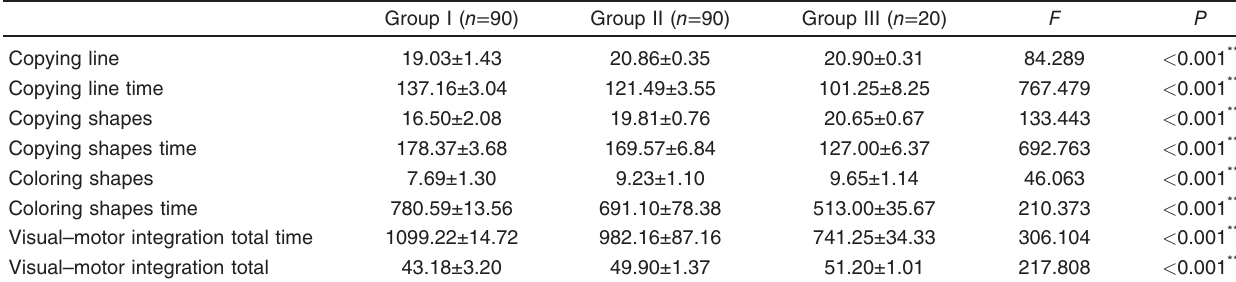
Table 1 Comparison among the studied groups in their performance in visual – motor integration